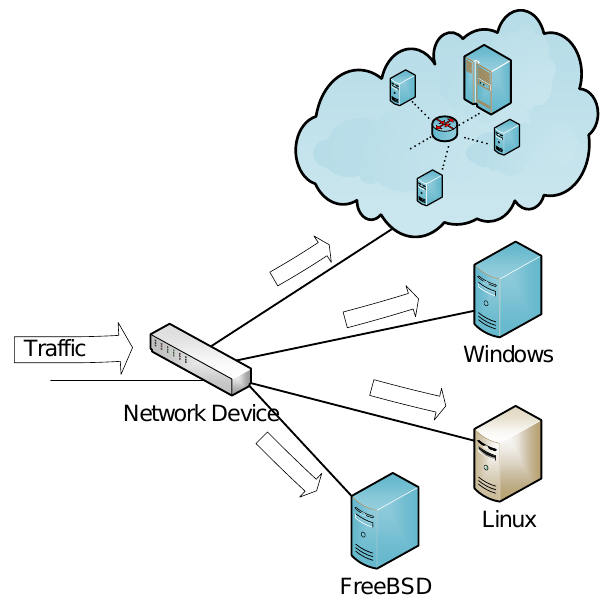
Figure 6. Network